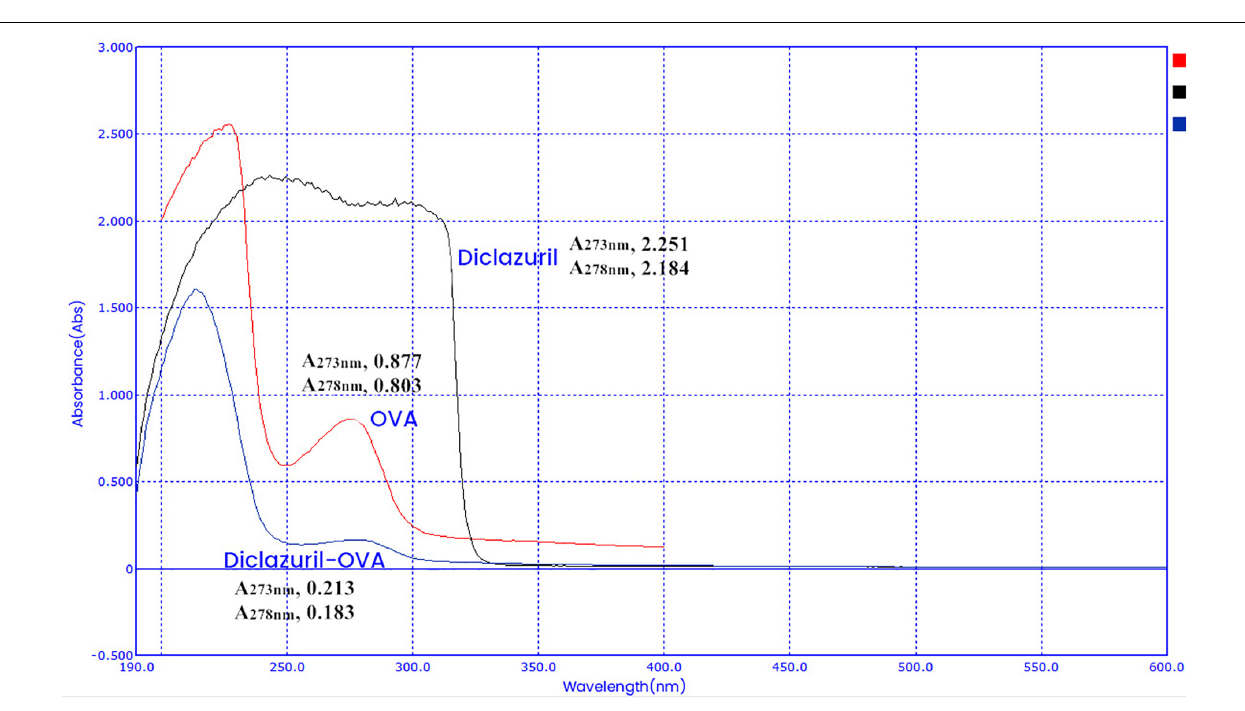
3%. Therefore, the ELISA could be stored at 2–8 ◦ C for at least 12